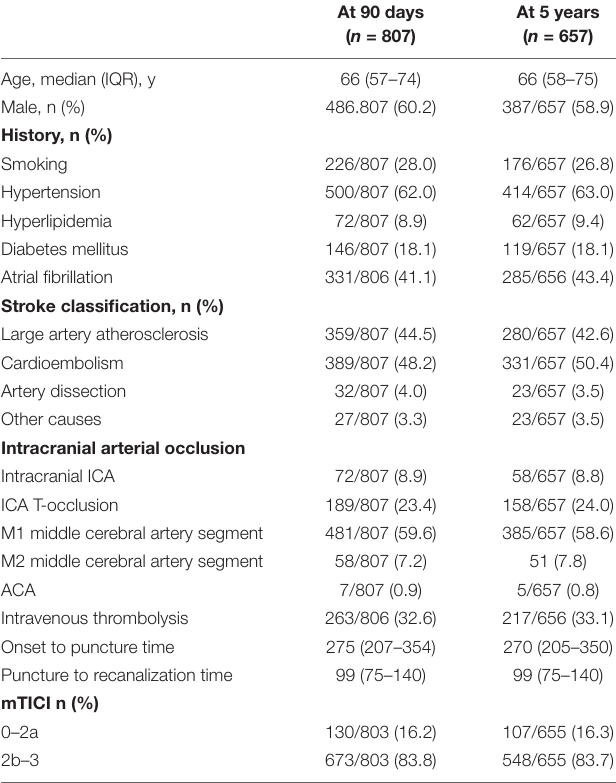
TABLE 1 | Baseline characteristics in the study